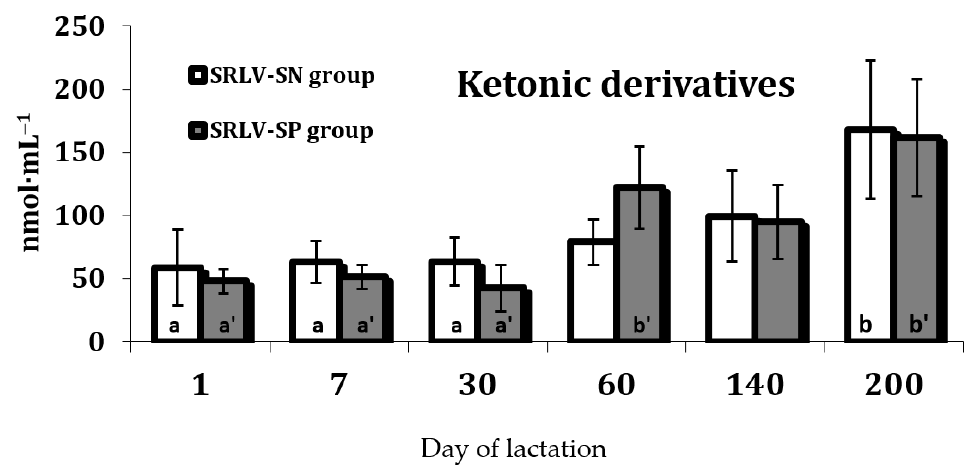
Figure 2. Ketonic derivatives of oxidatively modified proteins (nmol · mL − 1 ) in the serum of SRLV-SN and SRLV-SP goats during lactation. Values are expressed as means ± SEM; a, b—different letters indicate significant differences between stages of lactation within the SRLV-SN group at p < 0.05; a’, b’—different letters indicate significant differences between stages of lactation within the SRLV-SP group at p < 0.05; SRLV-SP—small ruminant lentivirus seropositive goats; SRLV-SN—small ruminant lentivirus seronegative goats.